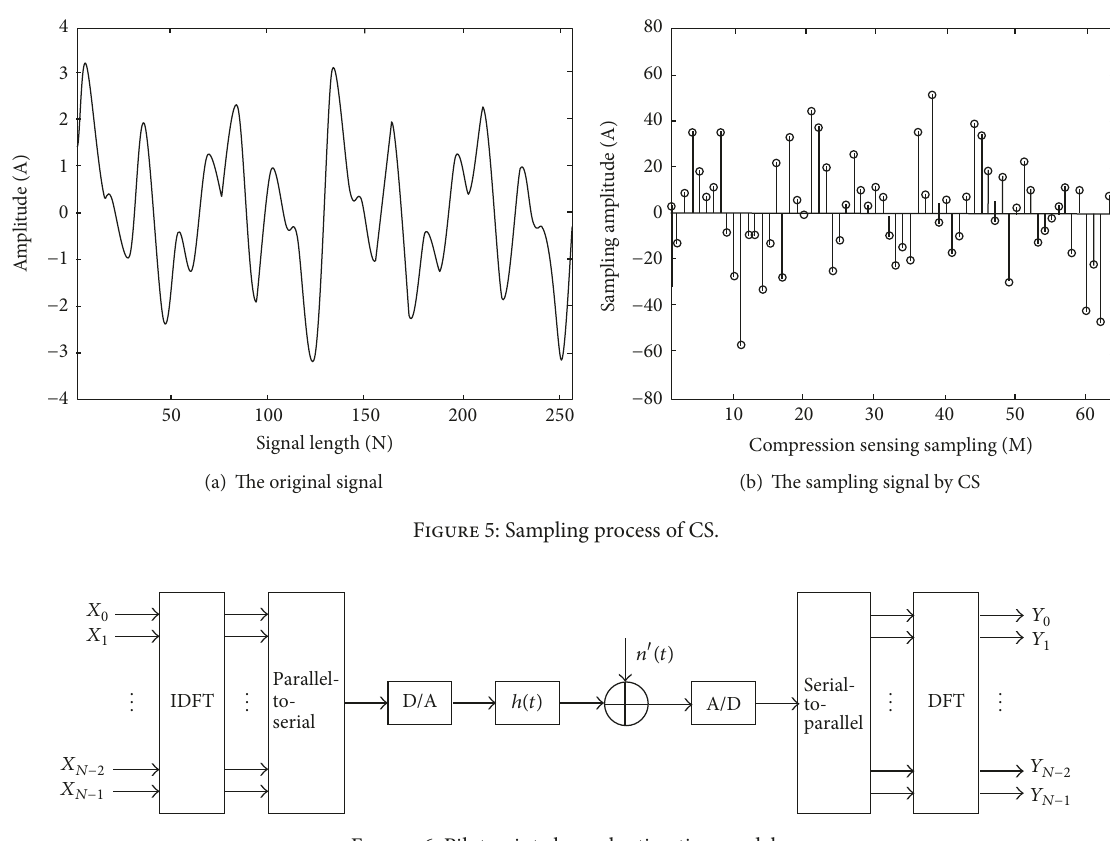
Figure 6: Pilot point channel estimation